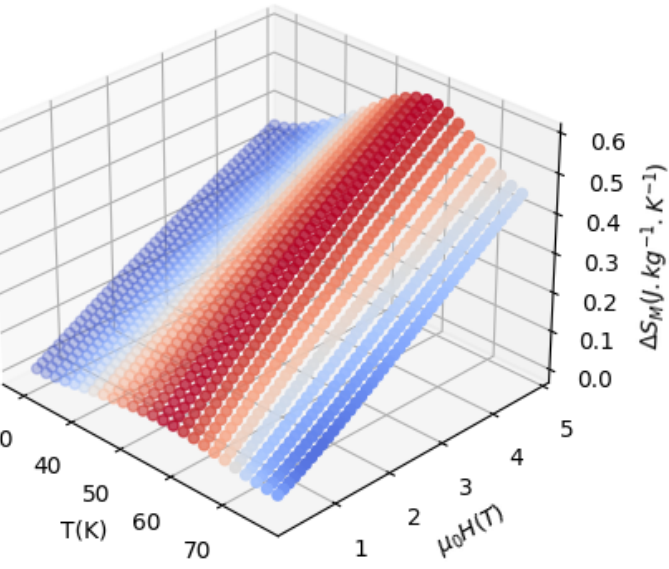
Figure 12. Magnetic entropy change vs. temperature for SmNi 3 under several magnetic fields.